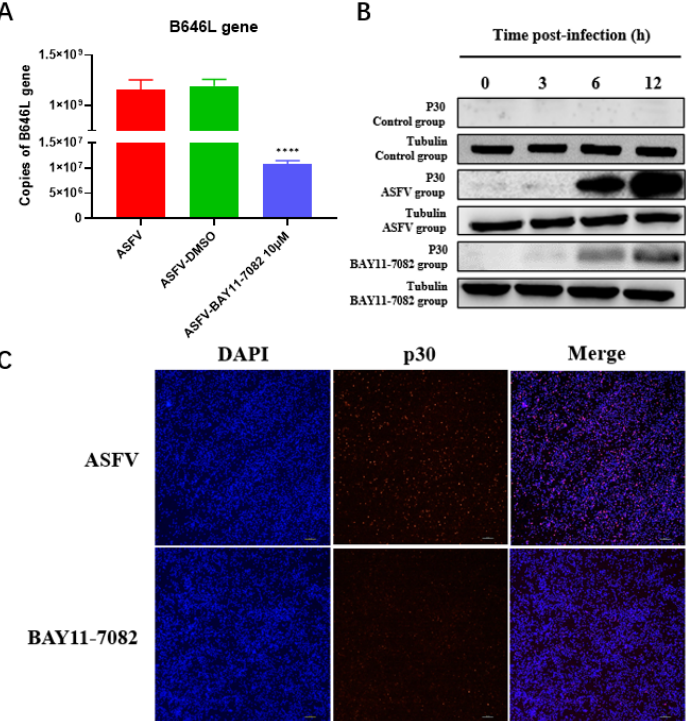
Figure 9. Antiviral activity of BAY11-7082 against ASFV. ( A ) PAMs infected with ASFV (1 MOI) at 37 °C and then cultured in fresh medium supplemented with 10 μ M BAY11-7082. The expression levels of ASFV p72 in PAMs were detected by real-time PCR analysis at 12 h. Each data represents results of three independent experiments (means ± SD). ( B ) ASFV p30 protein expression levels in cells treated with BAY11-7082 were evaluated by Western blotting. ( C ) Antiviral activity of BAY11-7082 against ASFV was determined in PAMs by IFA. PAMs were seeded in 24-well plates and infected with ASFV (1 MOI) at 12 h, and then incubated with RPMI 1640 supplemented with the indicated concentration of BAY11-7082. The p30 protein was used as an indicator of ASFV infection, and IFA was performed using mouse anti-p30 protein antibody and goat anti-mouse IgG Alexa Fluor. Nuclei were counterstained with DAPI (blue). Each datum represents results of three independent experiments (means ± SD). The images above represent three independent IFA trials with similar results. Significant differences compared with the control group are denoted by **** ( p <